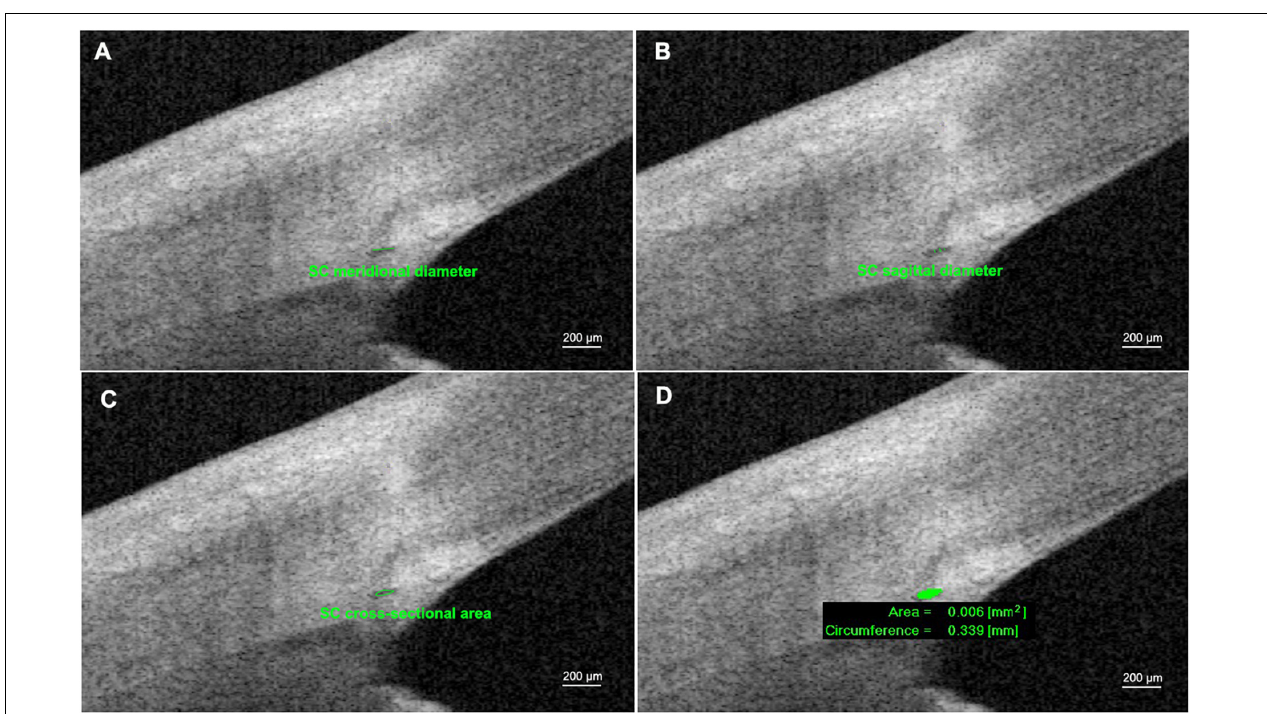
FIGURE 1 | Measurements of Schlemm’s canal (SC) using anterior segment optical coherence tomography. (A) SC meridional diameter was the distance of the longest axis of SC measuring from the posterior to the anterior SC end point. (B) SC sagittal diameter was defined as the distance between the superior and inferior outline of SC lumen (average of three measurements). (C,D) SC cross-sectional area (CSA) and circumference of SC (CCF) were obtained by automatic calculation process after manually pointing out the boundary of SC lumen.